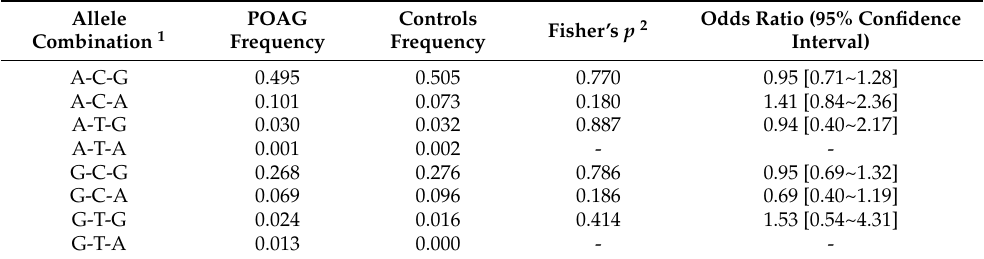
Table 5. Combined allelic effect of rs2472493 ( ABCA1 ), rs7636836 ( FNDC3B ), and rs61275591 ( ANDPT55 - MAP3K1 ) variants in primary open-angle